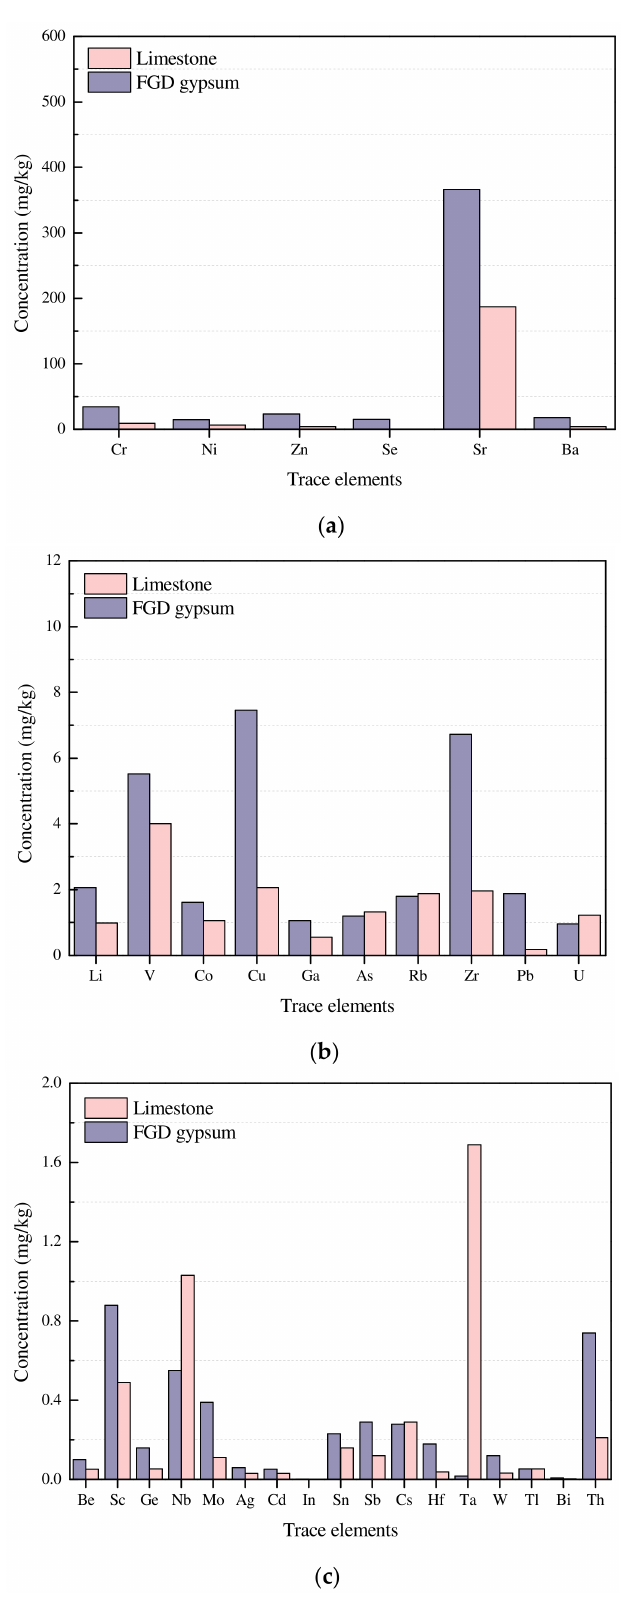
Figure 4. Comparison of trace elements with concentrations of lower than 400 mg/kg ( a ), 10 mg/kg ( b ), and 2 mg/kg ( c ) in limestone and FGD gypsum from the WN power